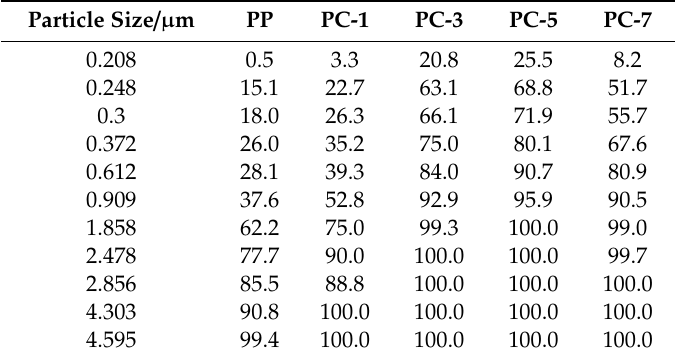
Table 5. Filtration e ffi ciency (%) of the meltblown samples to DEHS with primary particle size of